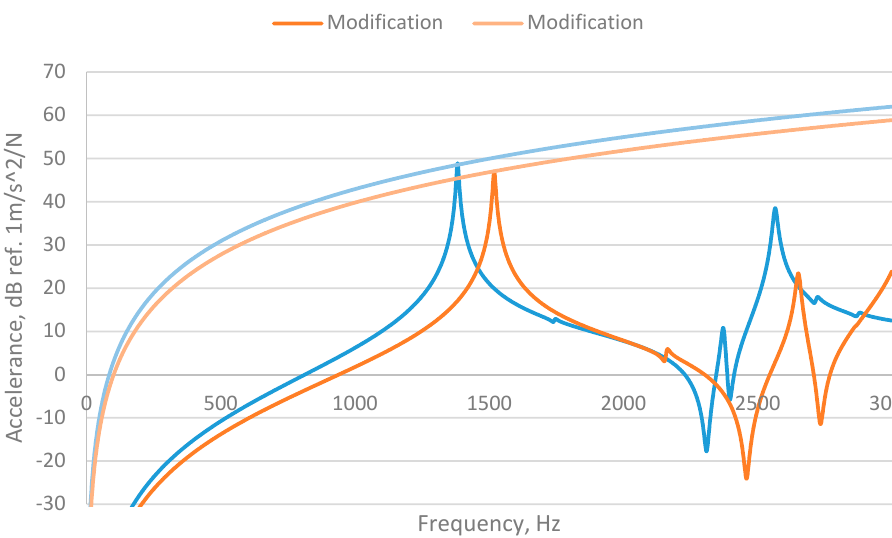
Figure 13. FRF comparison between the original and modification model.